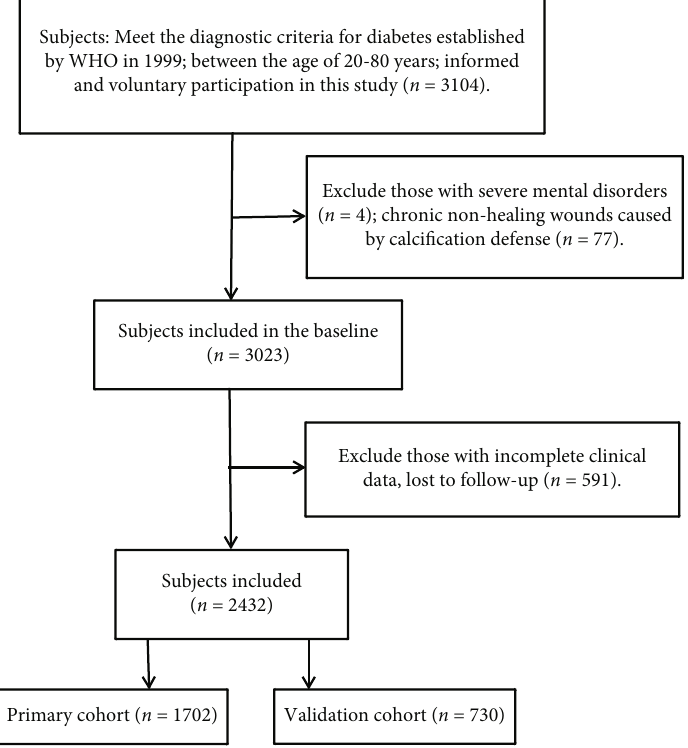
Figure 1: Flow chart of study